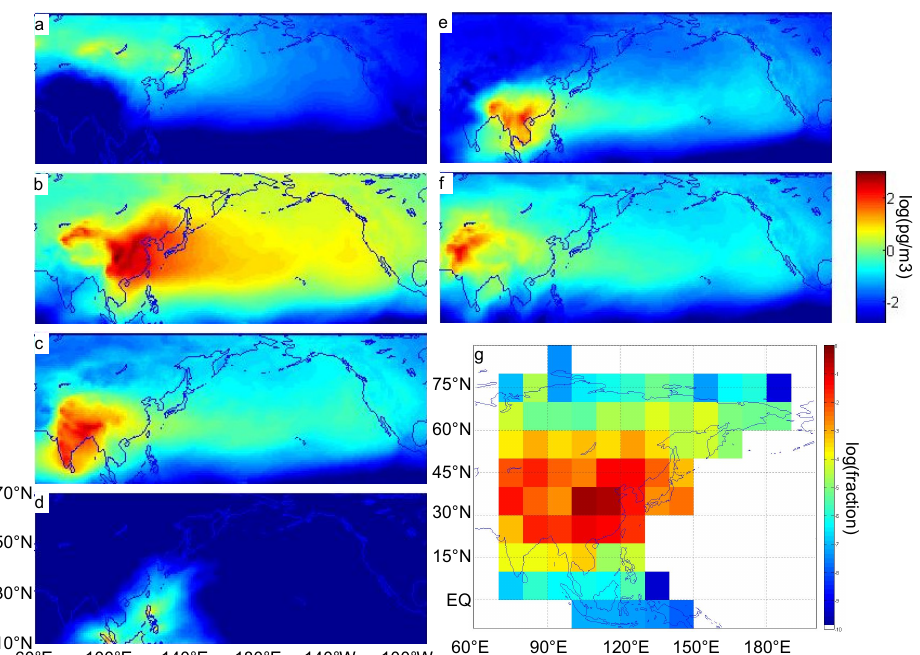
Fig. 4. Annual mean concentration of BaP induced by emissions from different Asian sources: (a–f) North Asia, East Asia, South Asia, Southeast Asia, the Indochina Peninsula, and West Asia, respectively; (g) contribution of the Asian BaP emission sources to the average BaP concentration over North America in 2004; each box represents a 10 degree by 10 degree area.